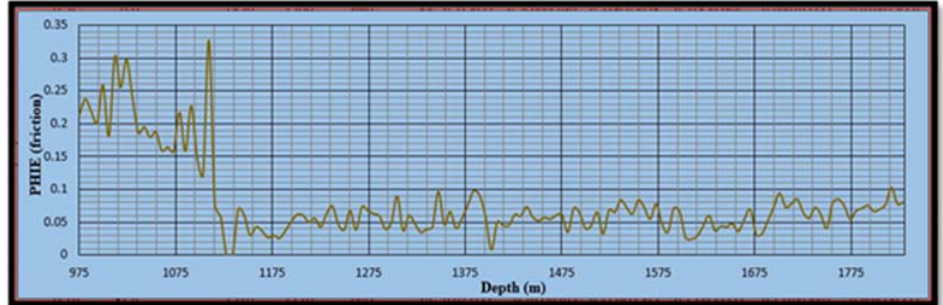
Figure 20. Effective porosity variation along the depth.